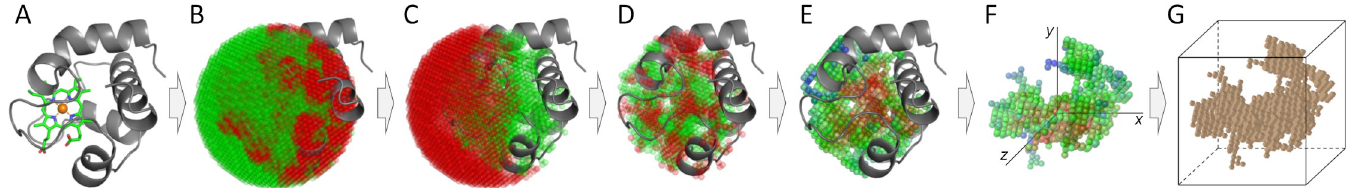
Fig 1. Voxelization of ligand-binding pockets. ( A ) Starting from a ligand-protein complex, a sphere centered on the geometric center of the ligand is created and filled with a 3D grid. Grid points ( B ) overlapping with the protein, ( C ) too far away from the protein, and ( D ) disconnected from the main grid structure are removed. Points to be removed are shown in red in B - D . Subsequently, ( E ) statistical potentials for ligand-protein interactions are calculated at each grid point and ( F ) the pocket principal axes are aligned to the Cartesian axes. ( G ) The voxel representation of a ligand-binding pocket is used as an input in deep learning.